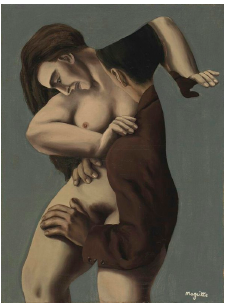
Figure 19. R. Magritte, Les Jours Gigantesques , 1928.